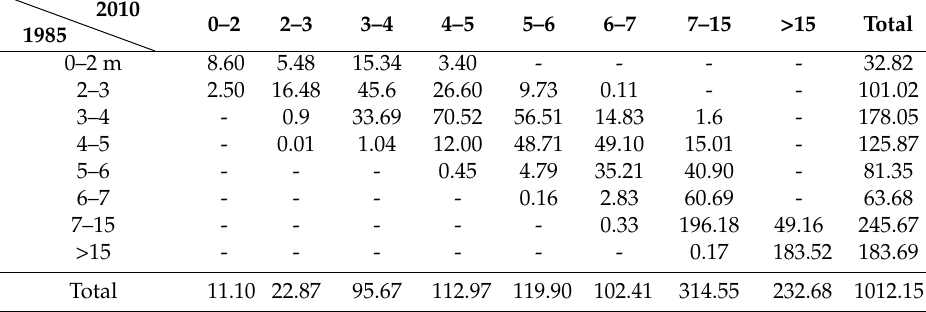
Table 5. The area transition matrix with different ranges of groundwater depth (km 2